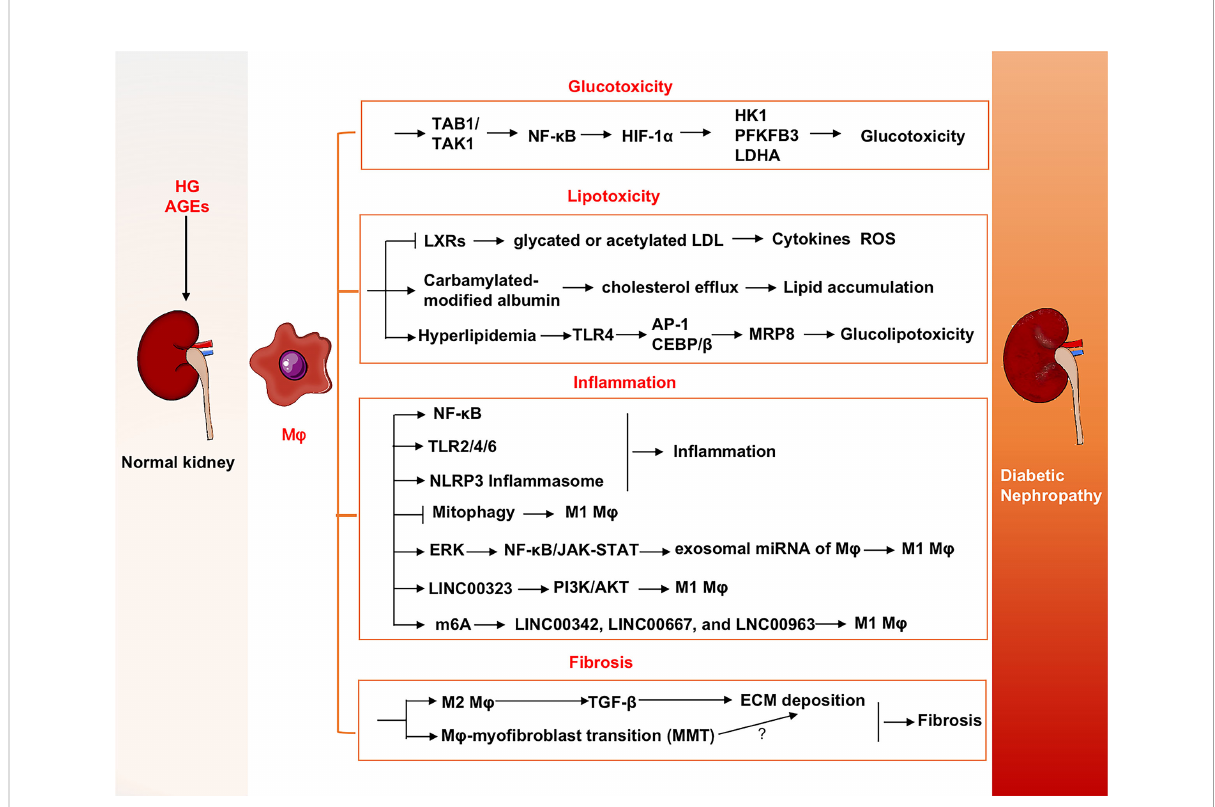
FIGURE 3 Roles of macrophages in DN progression. Macrophages contribute progression of DN via glucotoxicity and lipotoxicity-induced injuries, in fl ammation and fi brosis in kidney. DN, Diabetic nephropathy; ERK, Extracellular signal-regulated kinase; FTO, Fat mass and obesity-associated; HIF-1 a , Hypoxia-inducible factor-1 a ; HK1, Hexokinase-1; LDHA, Lactate dehydrogenase A; LDL, Low-density lipoprotein; LncRNAs, Long noncoding RNAs; LXRs, Liver X receptors; MMT, Macrophage-myo fi broblast transition; MRP8, Myeloid-associated protein 8; PDGF, Platelet- derived growth factor; PFKFB3, 6-phosphofructo-2-kinase/fructose-2, 6-biphosphatase 3; TAB1, Transforming growth factor beta-activated kinase 1-binding protein 1; TAK1, Transforming growth factor beta-activated kinase 1; TLR4, Toll-like receptor